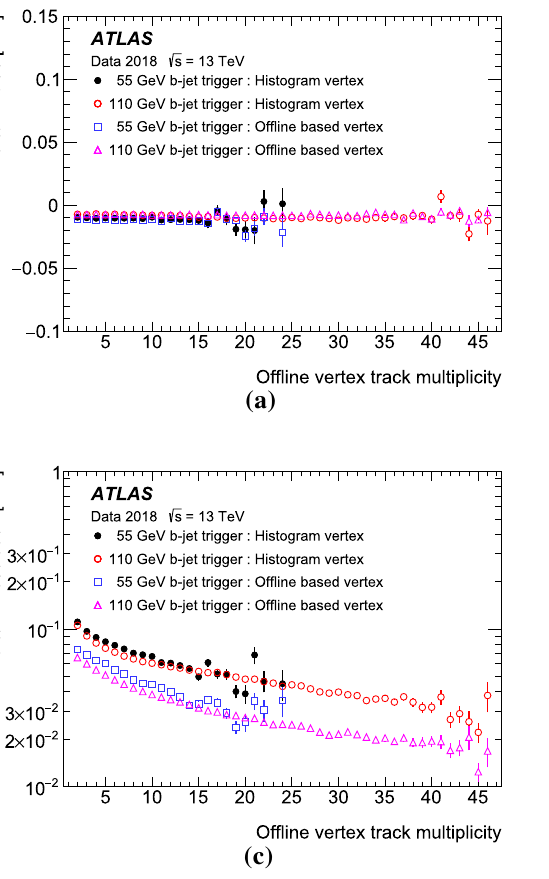
Fig. 43 The trigger vertex algorithm bias and resolution in the z posi- tion along the beamline, for low and intermediate E T b -jet triggers. Shown are the a bias, and c resolution with respect to the multiplicity of